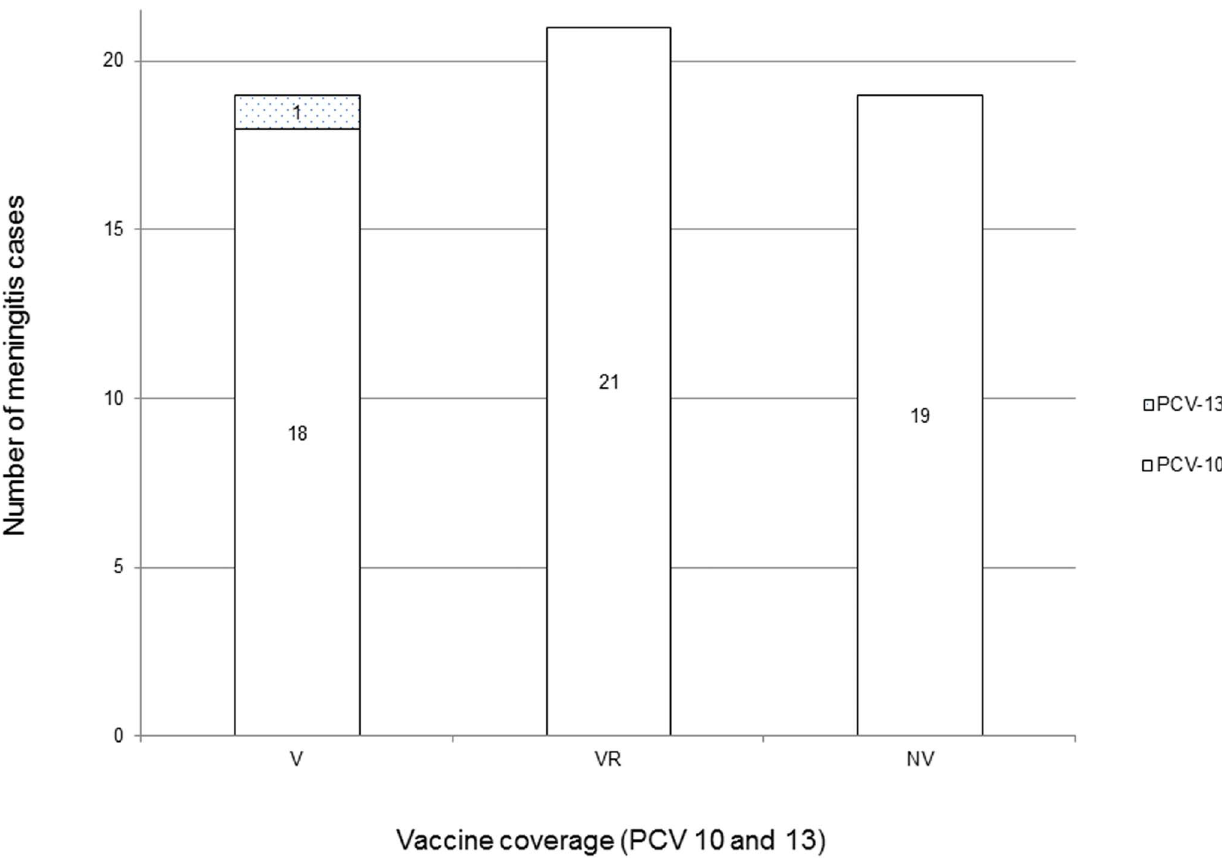
Figure 1. Vaccine coverage of pneumococcal serotypes in meningitis, Karachi and Hyderabad, Pakistan; 2009–2013 in children 0– 59 months. (V= Vaccine serotypes, VR= Vaccine-related serotypes, and NV= non-vaccine serotypes).